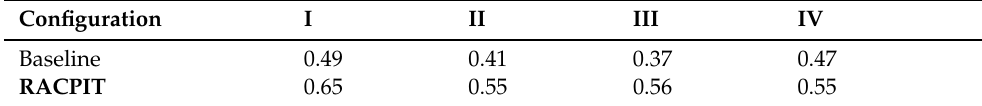
Table 2. F1 score of the baseline and RACPIT for all different configurations. Configuration